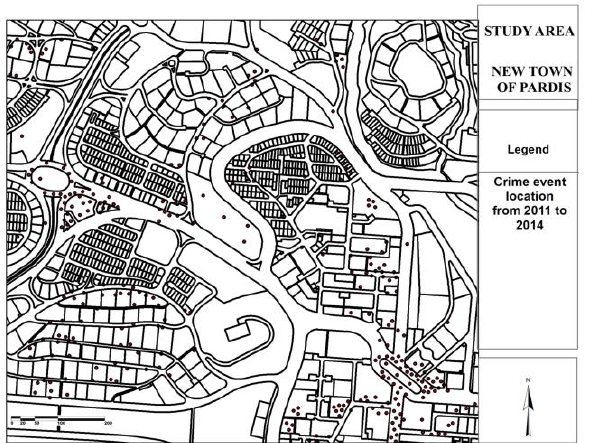
Fig. 2. The crime dot map of the study area